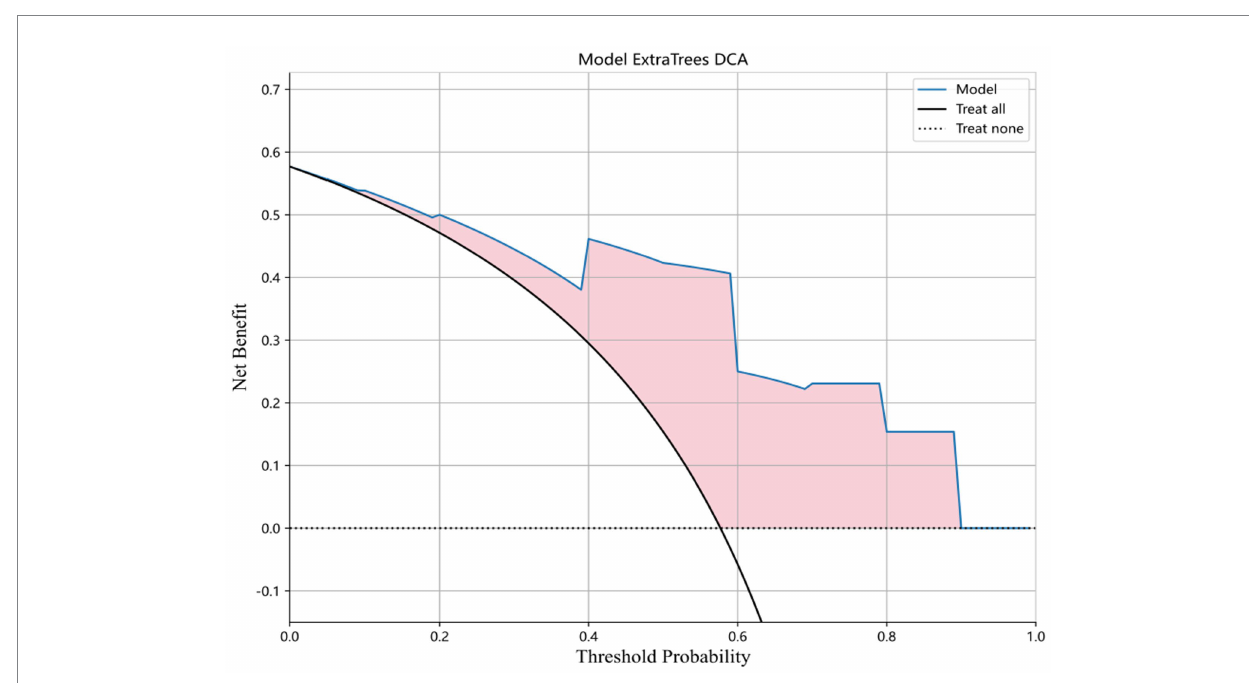
FIGURE 6 DCA for ExtraTrees model in the test set. The predictive model curves are significantly farther away from the two extreme lines, indicating a good overall net benefit in the